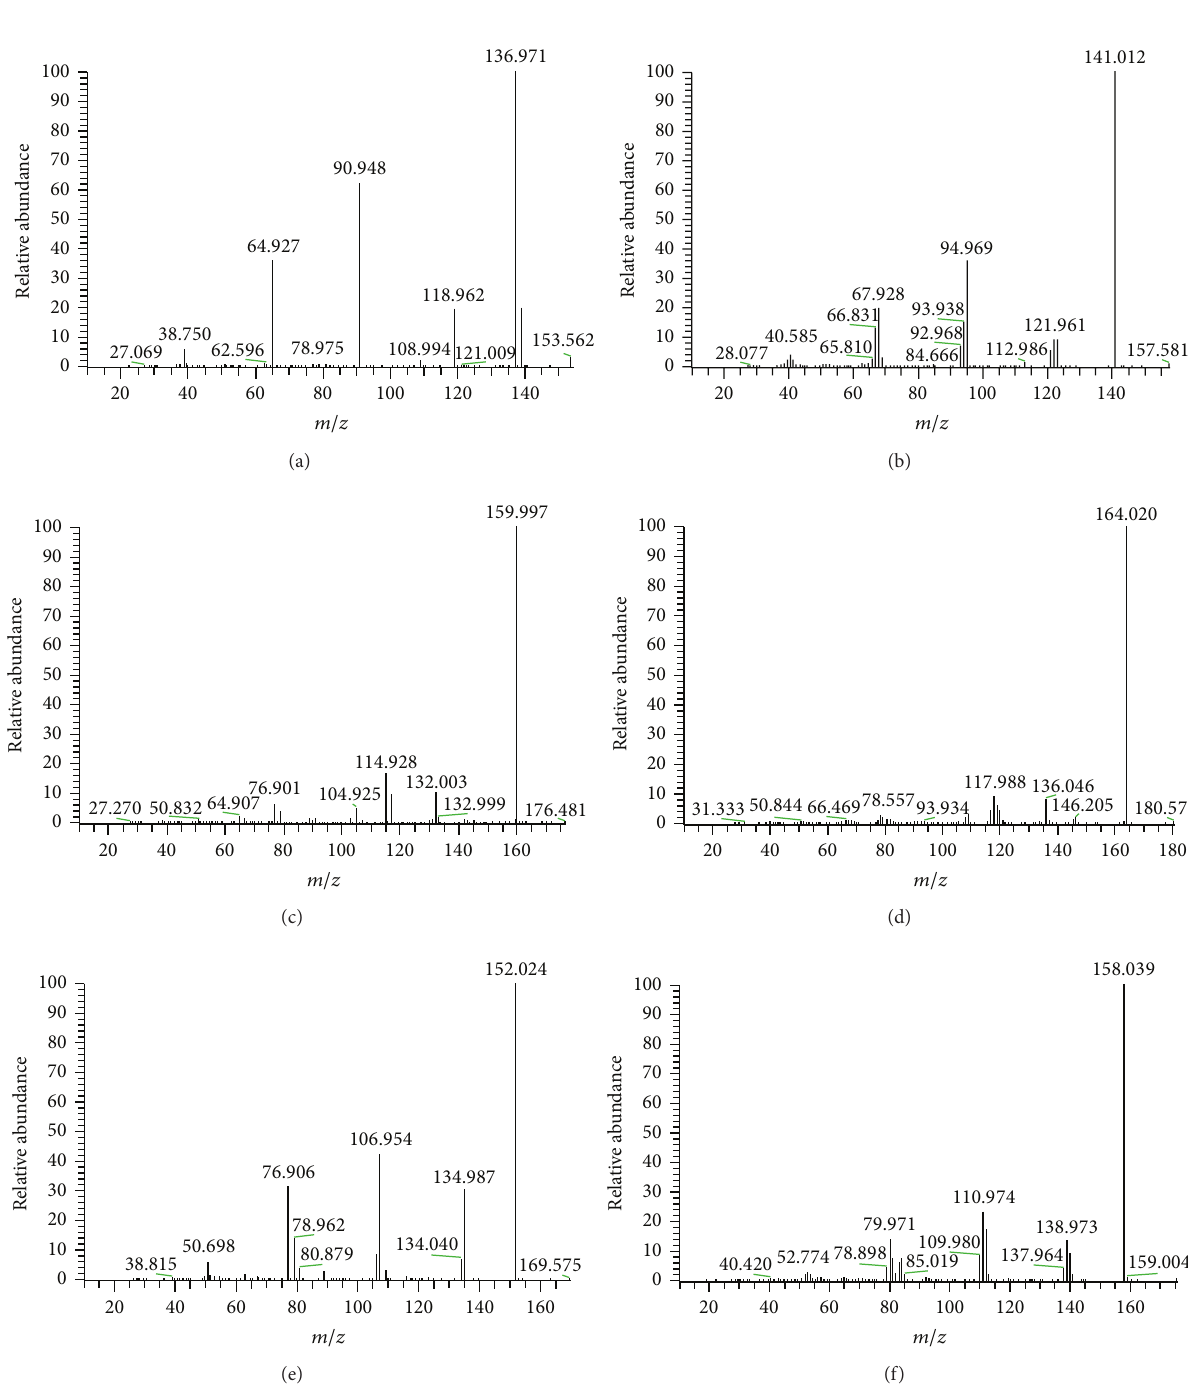
Figure 2: Product ion spectra for (a) dopamine, (b) dopamine-D 4 , (c) serotonin, (d) serotonin-D 4 , (e) norepinephrine, and (f) norepinephrine-D 6